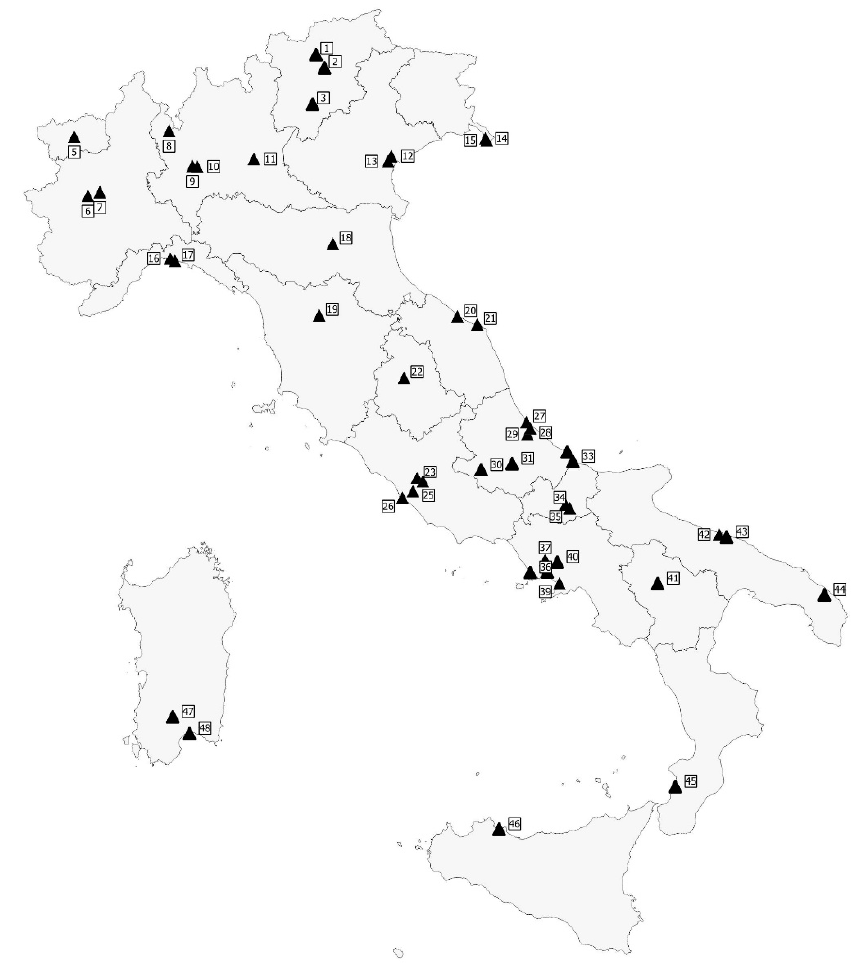
Figure 1. Geographic information system (GIS) map of the WTPs included in the study.